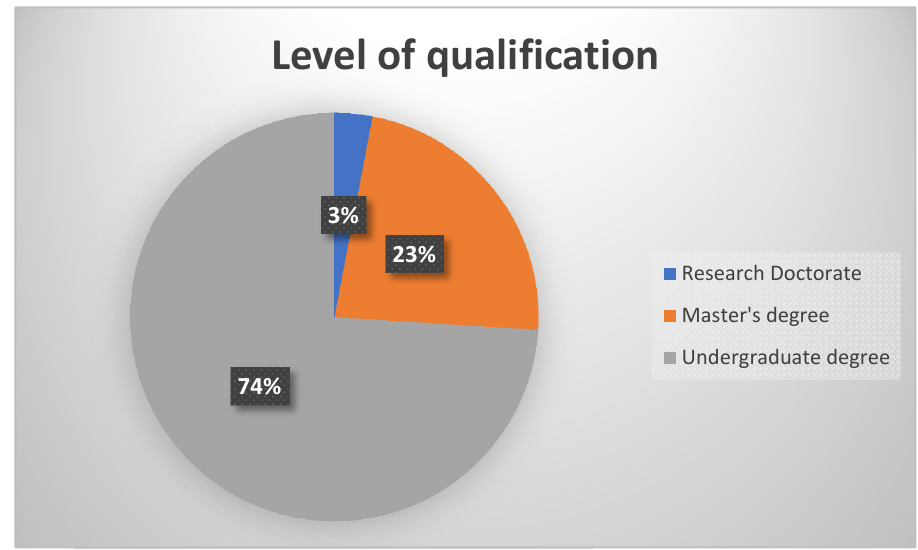
Figure 1. Participants’ level of highest qualification.